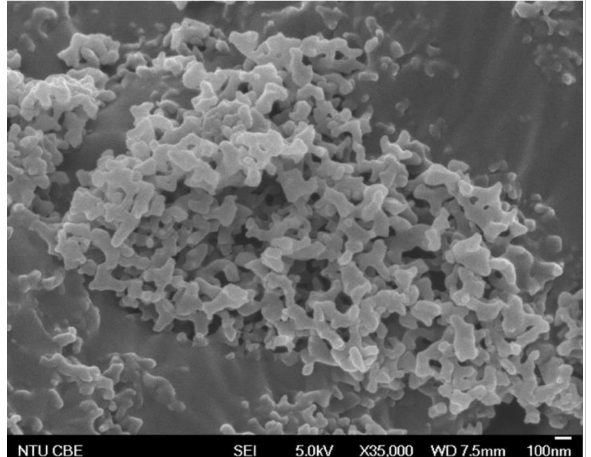
Figure 1. FESEM image of amorphous CUR–CHI nanoplex prior to its incorporation into buccal